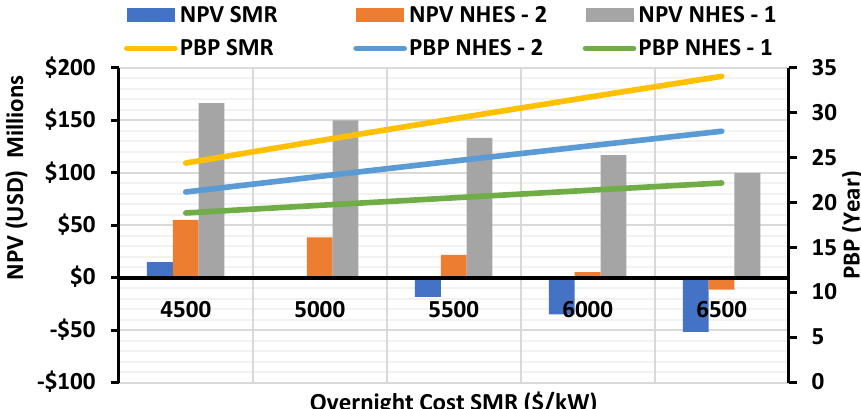
Figure 18. NPV and PBP vs. overnight cost of advanced SMR for PJM region .